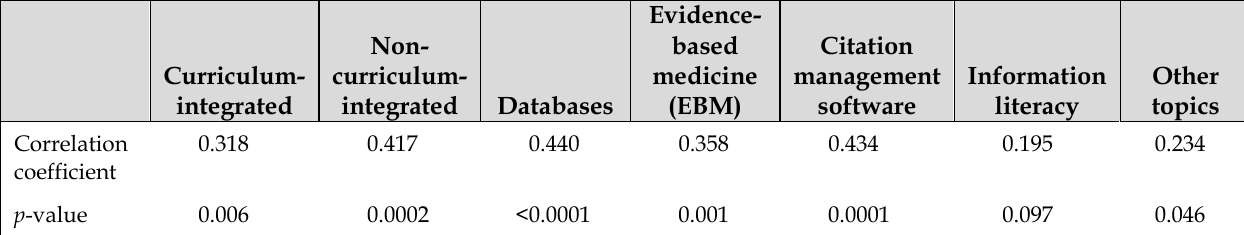
Table 1 Education staff size and frequency of teaching in various categories Non- Curriculum- curriculum- integrated